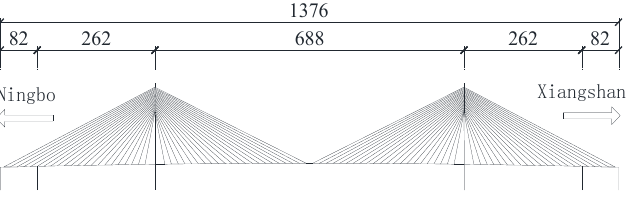
Figure 3. Layout of main bridge (m).